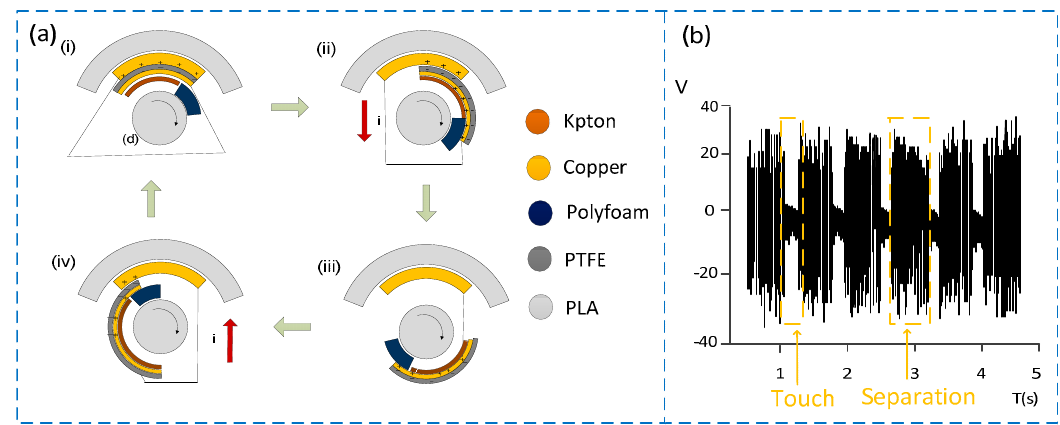
Figure 2. Working principle of the sensor. ( a ) Composition and working principle of the sensor; ( b ) signal waveform of the sensor.